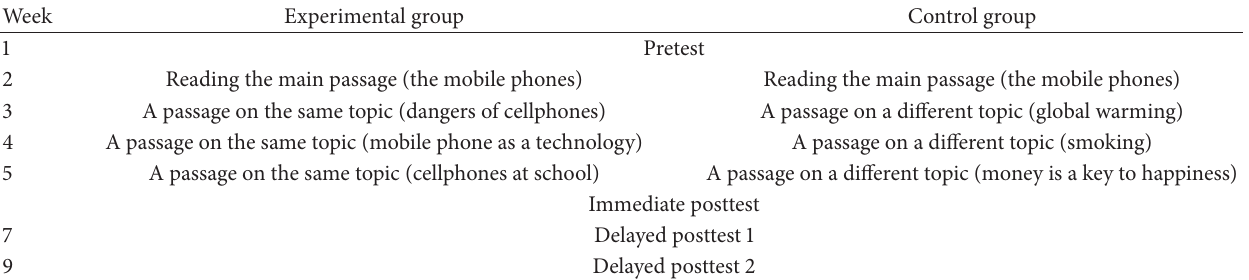
Table 3: Procedures of the